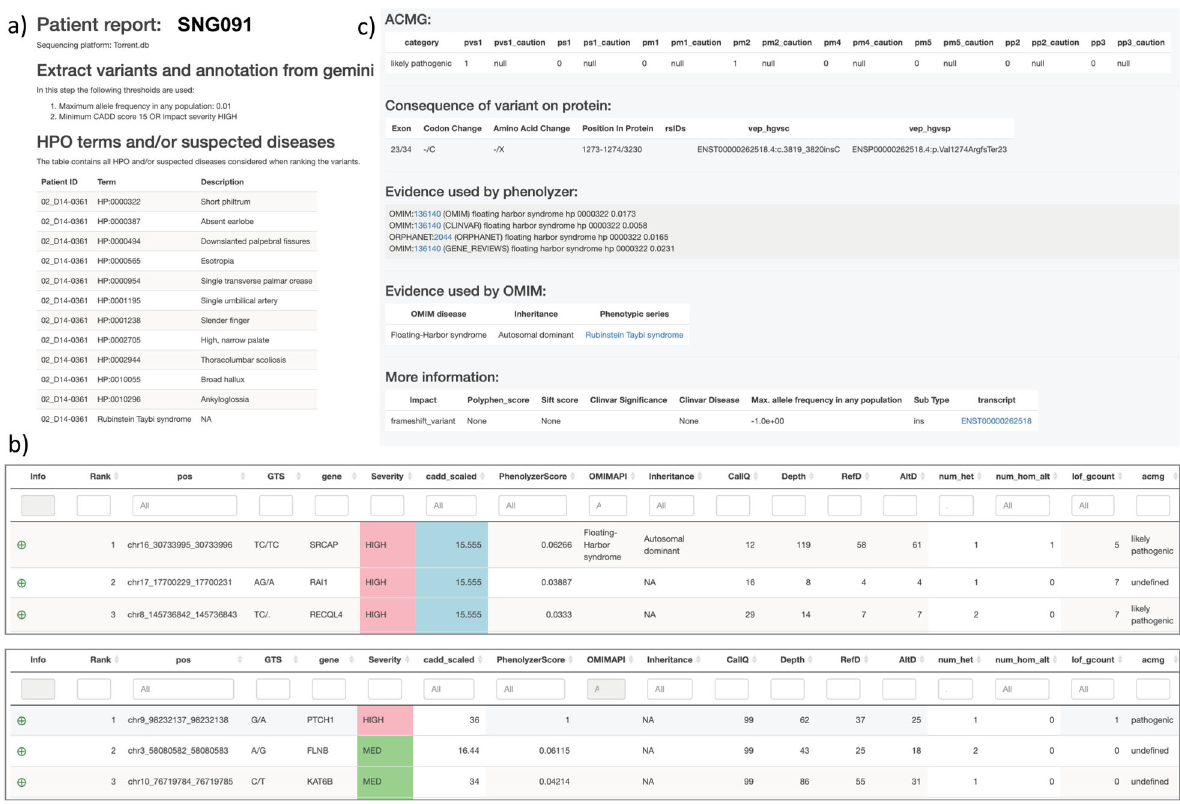
Fig. 1 Screenshots for sections of the patient reports output by the diagnostic pipeline. a shows the part of the .html fi le that provides input information including sequencing platform and HPO and OMIM disease terms; b shows the top three ranked candidates from two reports where the top candidate ranking is based on OMIM (upper panel) and Phenolyzer score (lower panel). Further columns to the right of the Phenolyzer score provide information from the OMIM API, mode of inheritance, CallQ, total read depth, read depth for the reference allele, read depth for the alternative allele, number of heterozygotes in the cohort, number of homozygotes in the cohort, total number of HIGH impact variants in the given gene across the cohort and ACMG classi fi cation. The patient report variant table can be fi ltered on one or more columns, as desired by the clinician or researcher. Clicking on the green dot to the left of the rank 1 variant in the upper panel shows c the evidence used to diagnose this particular variant as Floating Harbor Syndrome based on the OMIM Phenotypic Series for Rubinstein Taybi